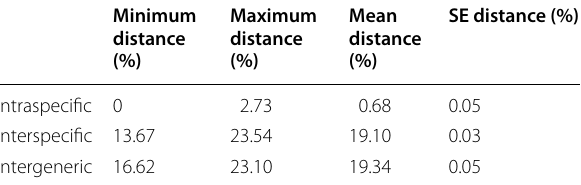
Table 5 Distribution of sequence divergence Minimum distance